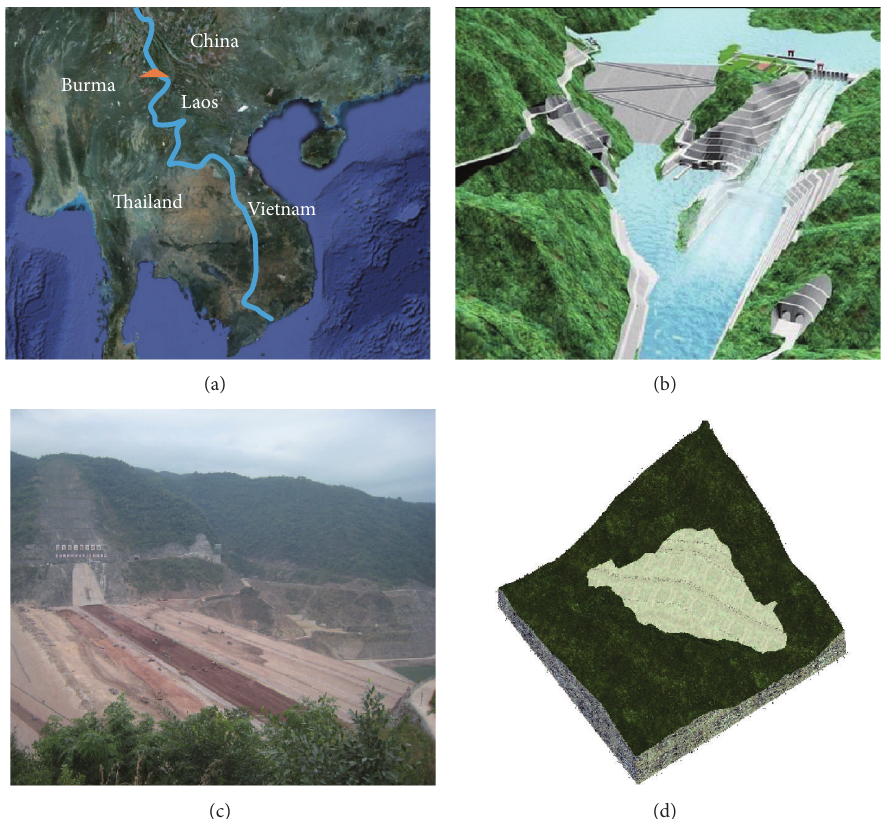
Figure 2: Nuozhadu dam. (a) Nuozhadu dam location, (b) project blueprint, (c) Nuozhadu dam under construction, and (d) dam site geomorphology.